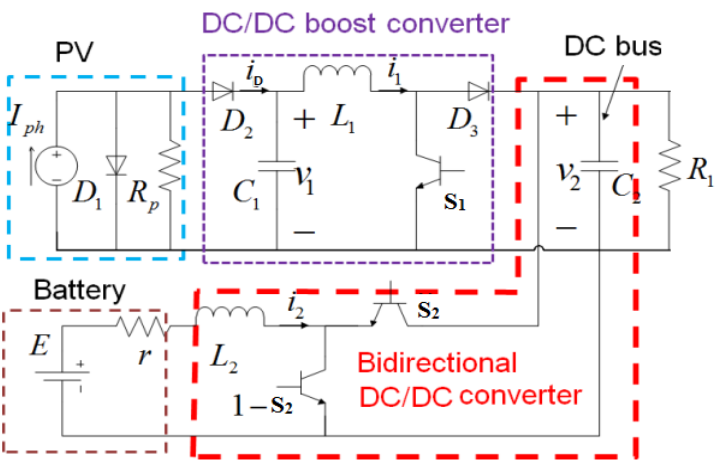
Figure 30. DC-microgrid system circuit for stability analysis.